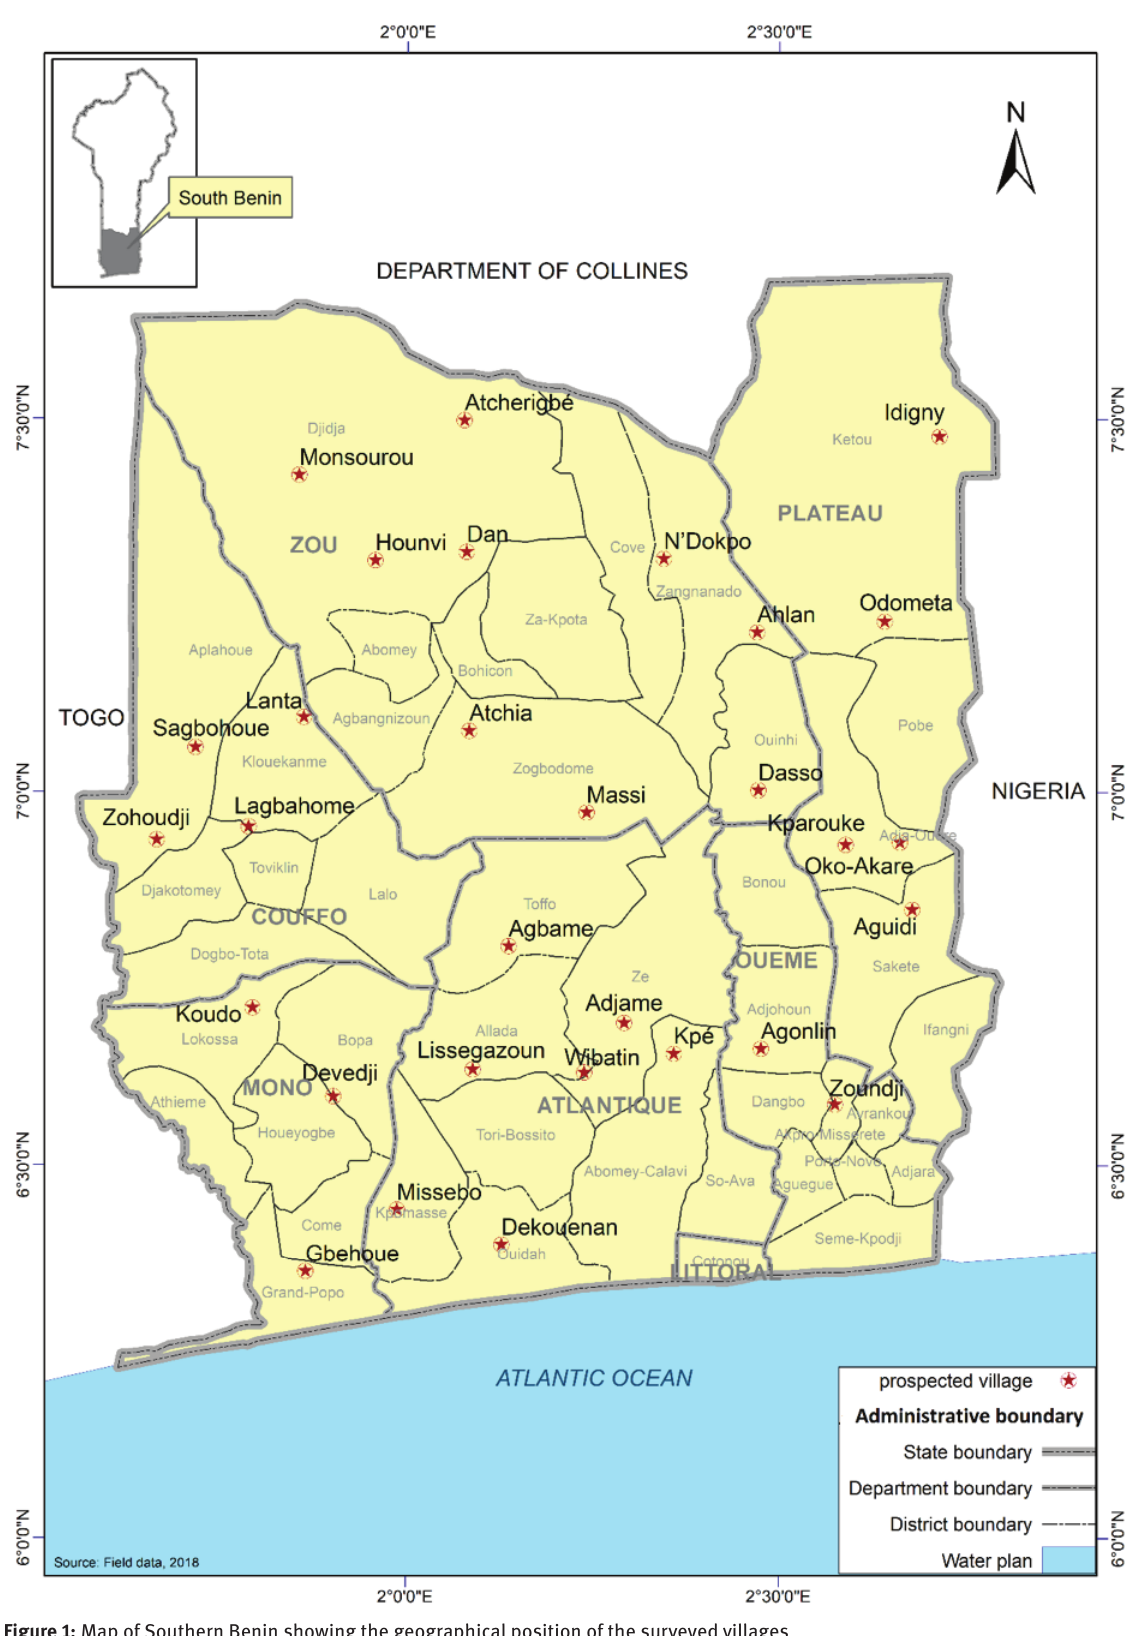
Figure 1: Map of Southern Benin showing the geographical position of the surveyed